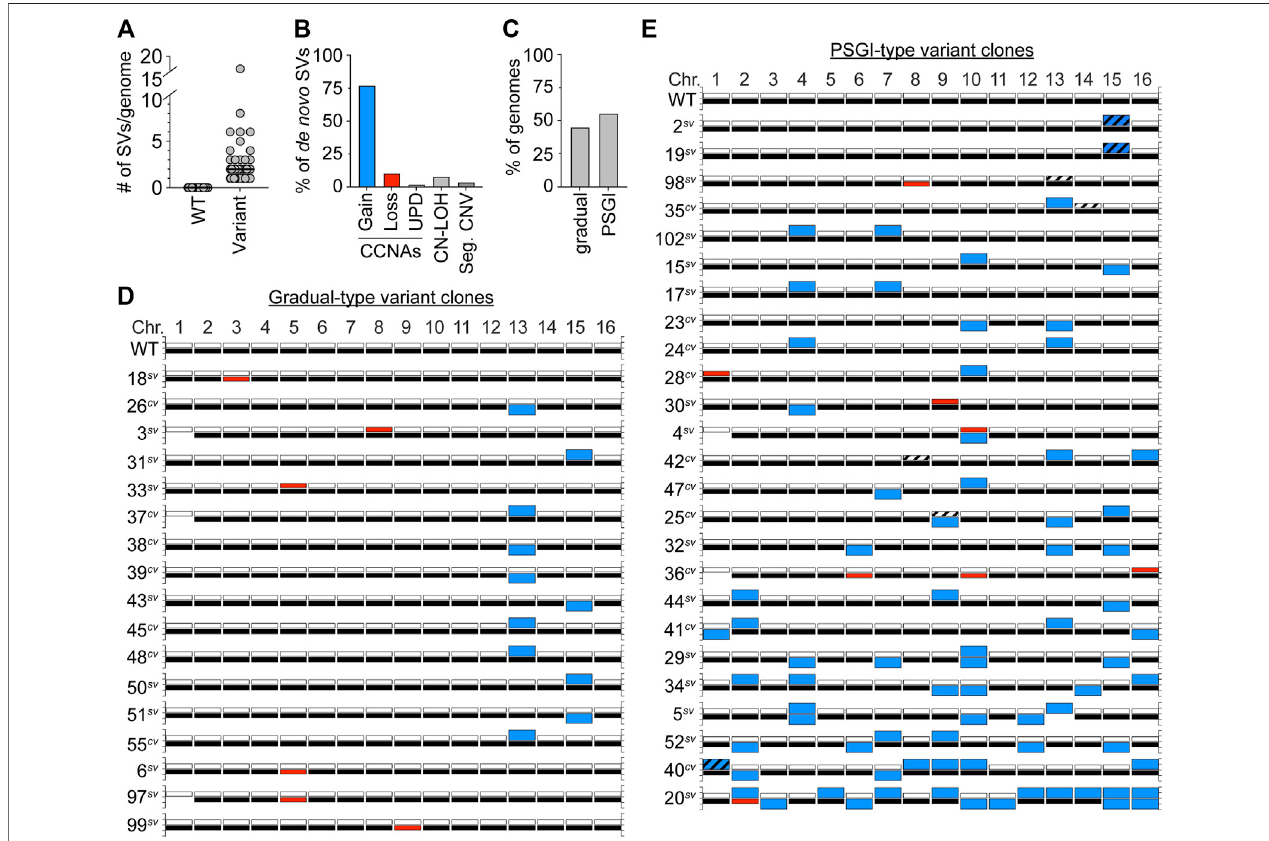
FIGURE2| Variantclonesharbornumerous denovo SVs. (A) .ThenumberofSVspresentinWTandvariantgenomes.Eachgreycircledenotesanindividualclone. Black bars denote the median number of SVs for each set. (B) . The percentage of SVs that constitute whole chromosomal gain, loss, uniparental disomy (UPD), copy- neutral loss-of-heterozygosity (CN-LOH), or segmental copy number variations (Seg. CNV). (C) . The percentage of variant genomes displaying either a gradual-type or PSGI-type of mutagenesis. (D,E) . Karyotypes of the YJM311 parent and all variants arising by gradual-type and PSGI-type of aneuploidization. For each chromosome, white bars represent homolog “ a ” and black bars represent homolog “ b ” . Blue bars denote chromosomal gains, red bars denote chromosomal losses. Striped bars denote tracts of CN-LOH. Loss of Chr1 b has been excluded from analysis in A, B, and